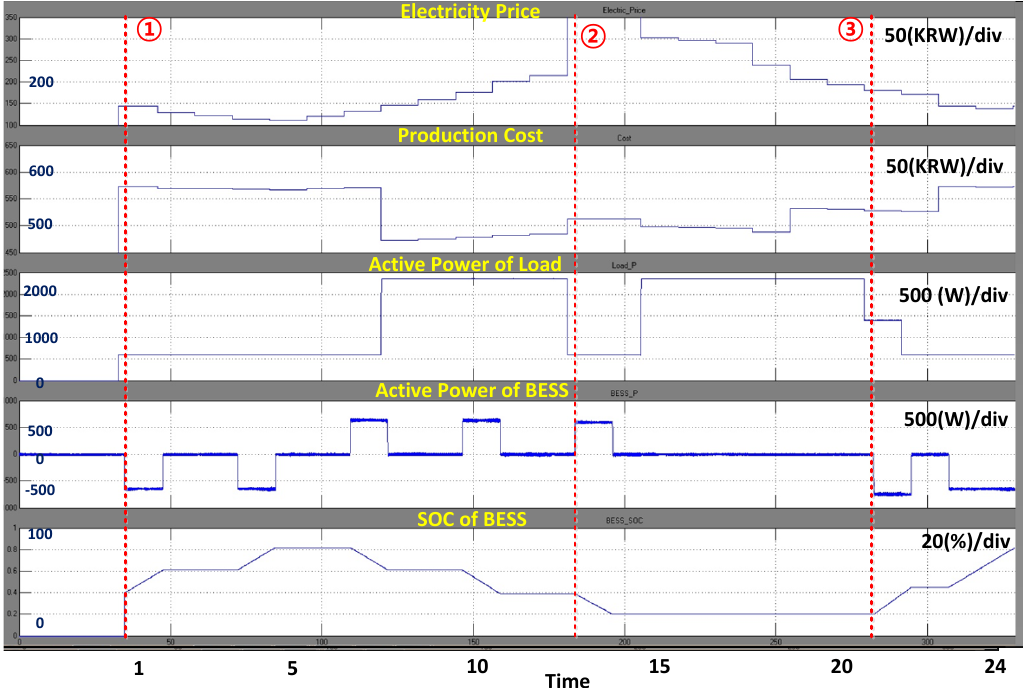
Figure 12. HILS test result of scenario 3.